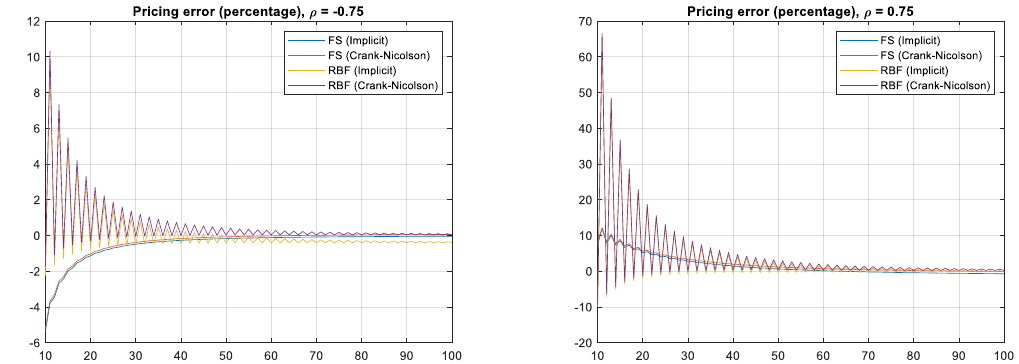
Figure 2. Pricing errors (in percentages) with respect to the number of partitions of space dimensions for ρ = − 0.75 ( Left ) and ρ = 0.75 ( Right ), respectively.